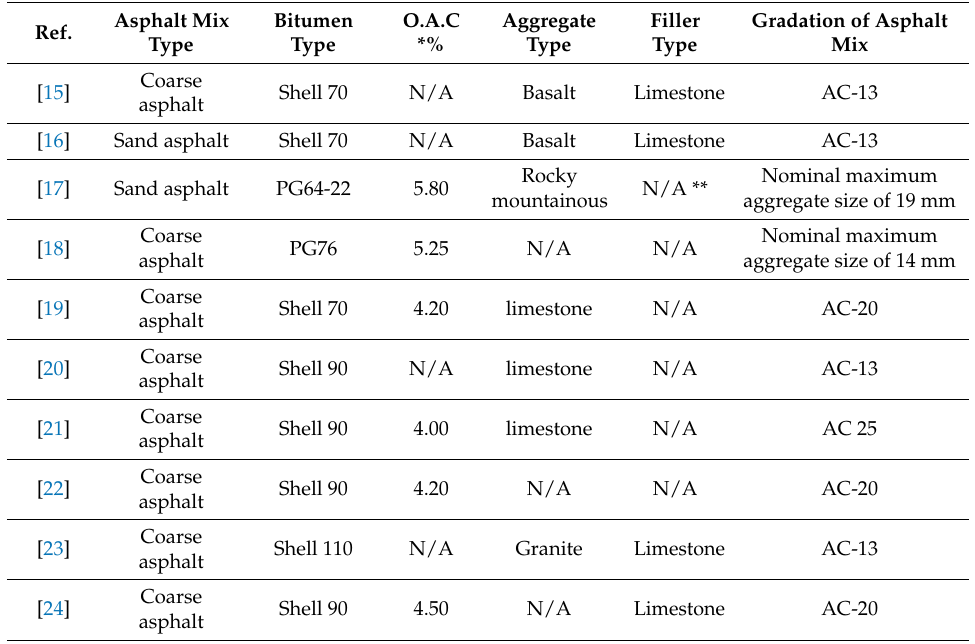
Table 1. Component of asphalt mixes modified with diatomite